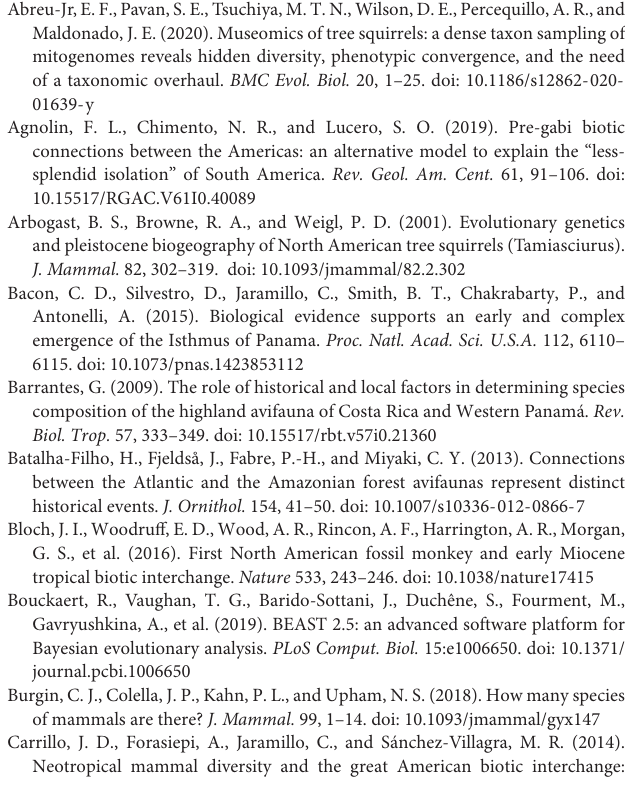
TABLE S2 | Alternative states of ancestral range estimated by DEC + J model in the global scale analyses. Node numbers are the same depicted in the phylogeny of Supplementary Figure S3 . TABLE S3 | Alternative states of ancestral range estimated by BAYAREALIKE + J model in the Neotropical scale analyses. Node numbers are the same depicted in the phylogeny of Supplementary Figure 5 . Areas acronyms are: Mexican transition zone (MEX), Mesoamerican dominion (MES), Pacific dominion